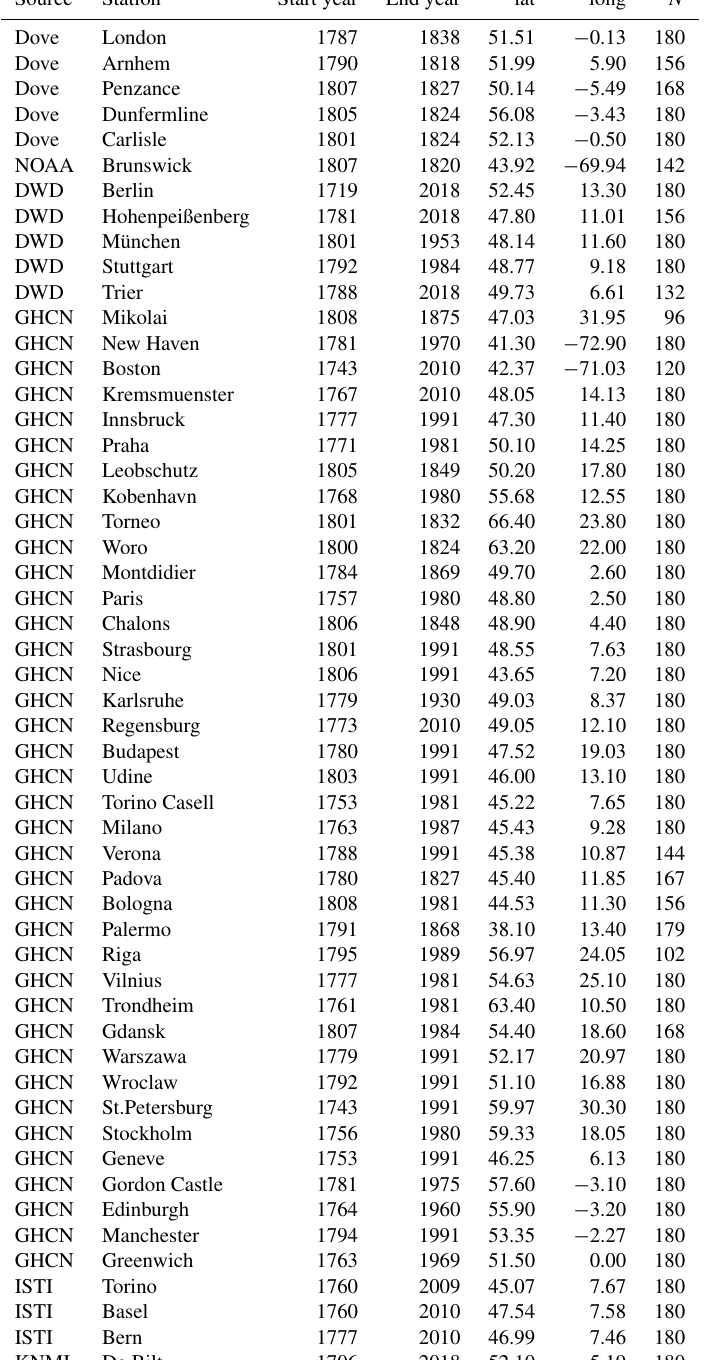
Table A1. Temperature observations from land stations used in this study; n is the number of available values in the 1806–1820 period. Sources are as follows. Dove: digitized from the collection of Friedrich Wilhelm Dove (Dove, 1838, 1839, 1842, 1845), NOAA: digitized from images held at the NOAA archive, DWD: German Weather Service, GHCN: Global Historical Climatology Network (Lawrimore et al., 2011), ISTI: International Surface Temperature Initiative (Rennie et al.,